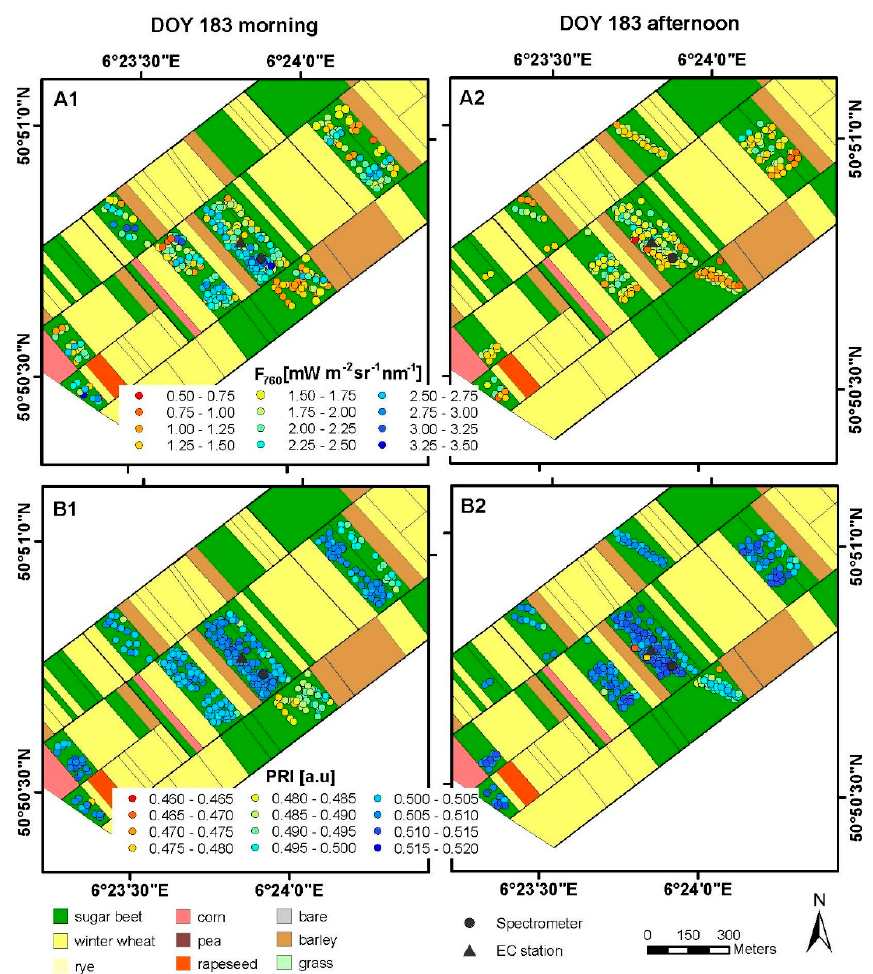
Figure 3. Airborne based F 760 and PRI measurements acquired on DOY 183 (1 July 2008) over sugar beet (colored circles) superimposed over a land cover map. Left column: measurements taken before solar noon. Right column: measurements taken after solar noon. Top row ( A1 , A2 ): Sun-induced fluorescence at 760 nm (F 760 ). Bottom row ( B1 , B2 ): Photochemical reflectance index (PRI). Black triangle and dot mark the location of the ground observations.